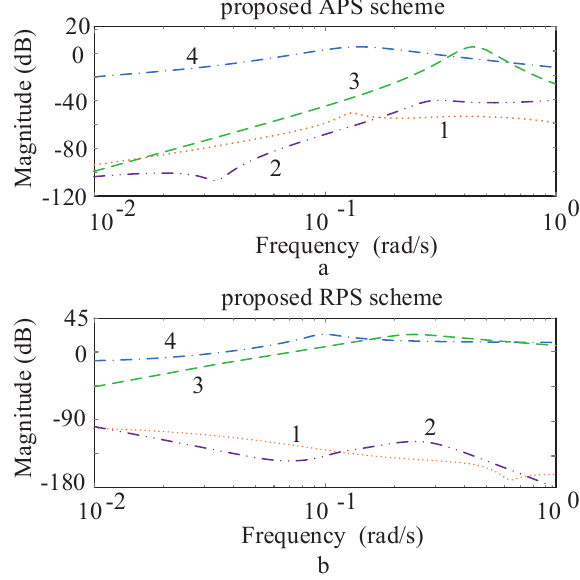
Figure 7. Open-loop gain of proposed ( a ) active ( b ) reactive power control loop for motor load with different inertia; 1 Grid-connected H = 1, 2 Grid-connected H = 2, 3 Islanding H = 1, 4 Islanding H =